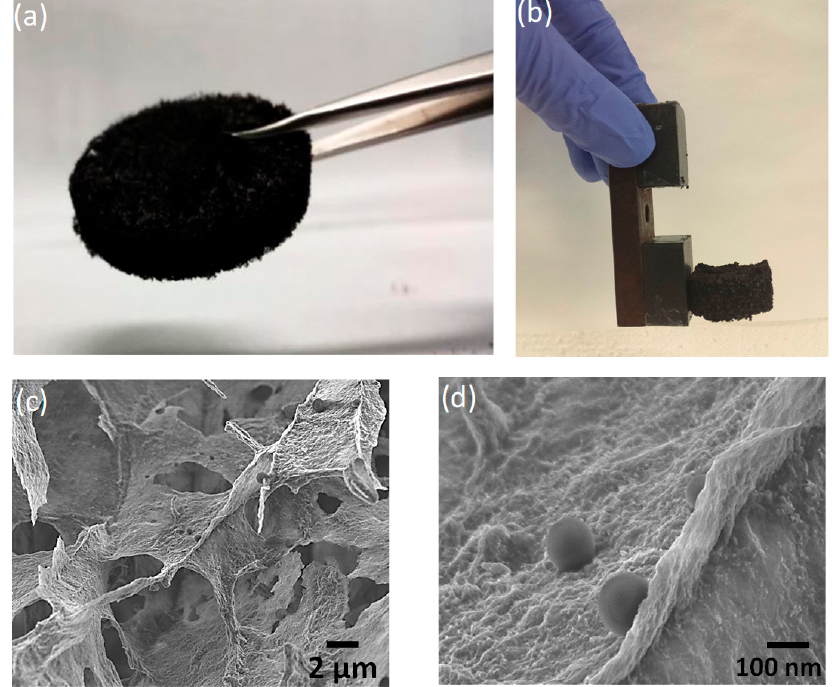
Figure 1. Digital images of the composite foam ( a ) and the foam in the contact with an external magnet ( b ). SEM images at different magnifications ( c , d ).